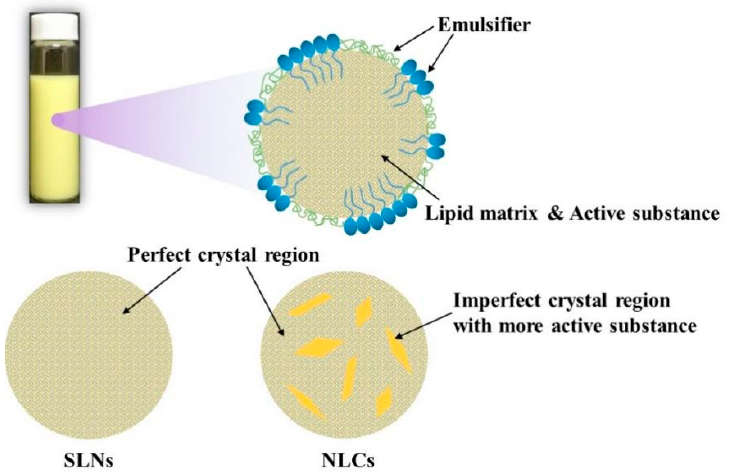
Figure 1. Schematic representation of the composition structures of lipid nanoparticles: SLNs and NLCs. (Adapted from [19]).